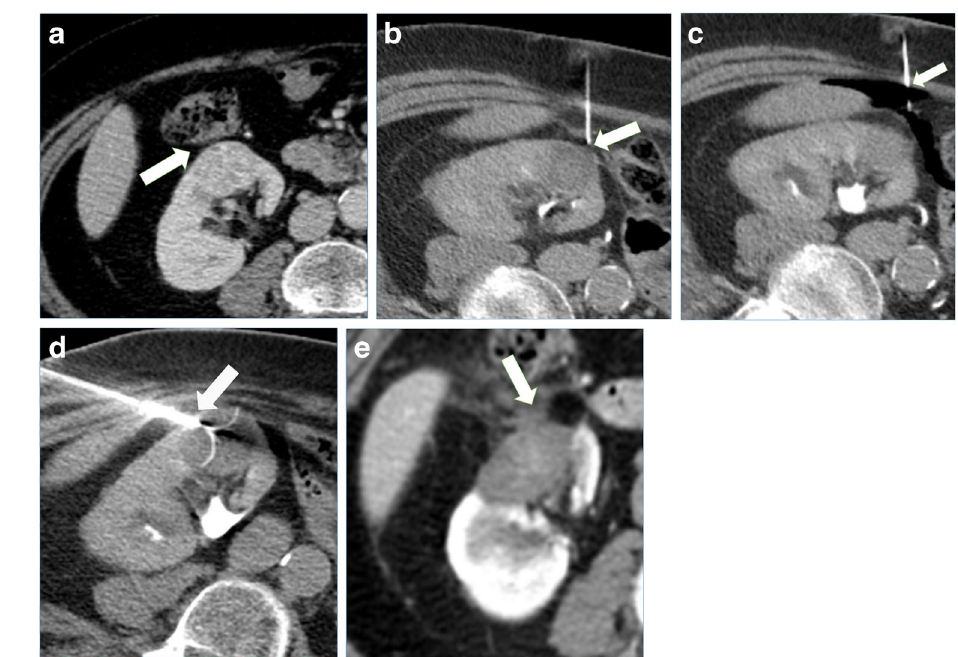
Fig. 4 Treatment of a right renal tumour with image guided thermal ablation with the assistance of CO2 injection. a contrast enhanced CT demonstrating an anterior right renal tumour close to the colon ( arrow ). b patient was positioned in lateral decubitus and a small needle was inserted in between the tumour and the colon ( arrow ). c CO2 was injected through the small needle ( arrow ) in order to achieve colon displacement. d an umbrella-shaped radiofrequency electrode ( arrow ) was inserted into the tumour from the opposite site of the colon, and slight traction made in order to displace the organ. e a contrast enhanced CT performed 24 h after the ablation demonstrated good ablation of the tumour ( arrow ) without